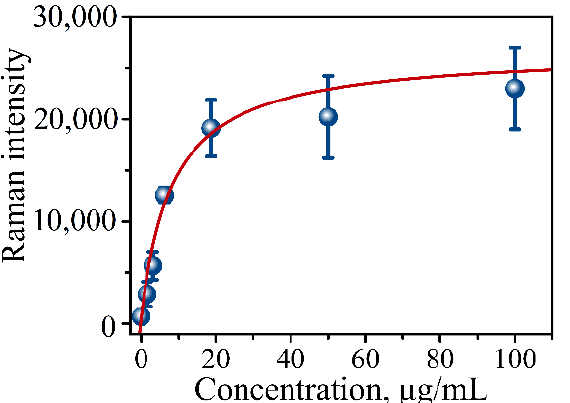
Figure 6. Calibration curve of CD18 protein lysate in serial dilutions measured using our established procedure for the immunoassay. Raman signal intensity was plotted against total µg/mL of CD18 lysate representing concentration of MUC4 at 0, 1.56, 3.13, 6.125, 18.75, 50, and 100 µg/mL concentrations. Table 1. Fitting parameters of the calibration curve in Figure 6 using Equation